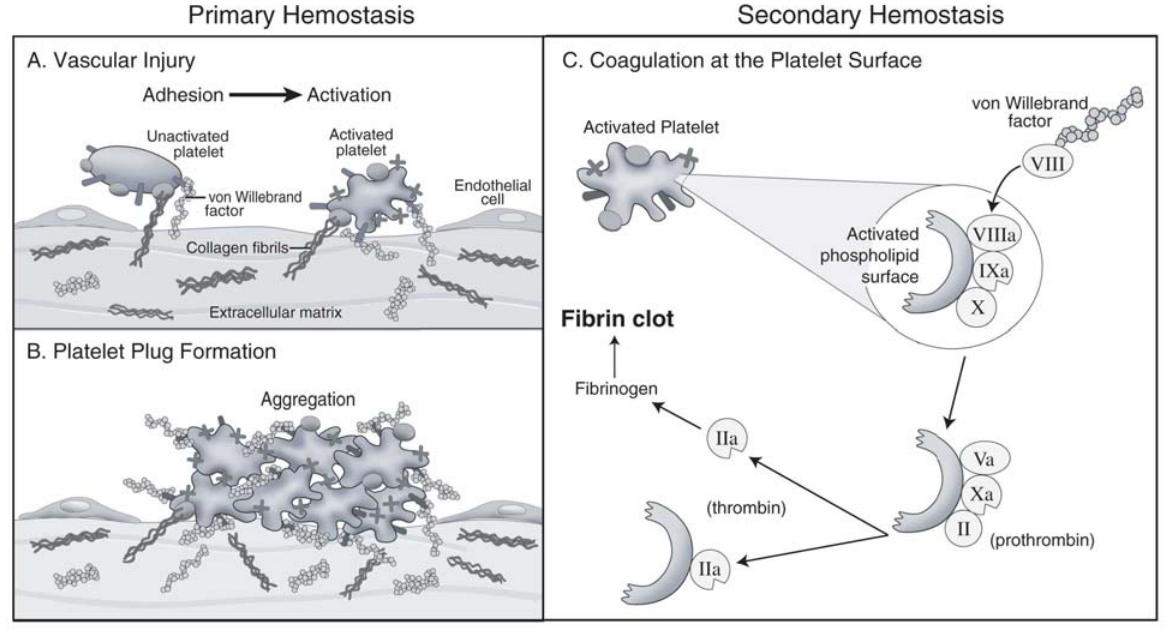
FIGURE 1. Overview of hemostasis . With vessel injury (panel A), circulating unactivated platelets tether to exposed subendothelial matrix via specific platelet receptors (circles and rods). With progressive adhesion, platelets undergo activation, shape change, and exposure of other activated receptors (crosses), culminating in formation of the platelet plug (panel B). At the activated platelet surface (crescentic forms, panel C), phosphatidylserine (a coagulation cofactor) is preferentially exposed at the outer membrane leaflet, thereby potentiating the activation of factor X to factor Xa and factor II (prothrombin) to factor IIa (thrombin). Thrombin is the critical enzyme that allows formation of the fibrin clot. Factors VIII and IX, the proteins that are deficient in hemophilia A and hemophilia B, respectively, are cofactor (in its activated form, factor VIIIa) and zymogen (factor IXa is the active enzyme) for the initial reaction depicted in panel C. Factor VIII normally circulates in the plasma bound to von Willebrand factor. Roman numerals signify coagulation proteins, functioning as either zymogens (circles), enzymes (excised circles), or cofactors